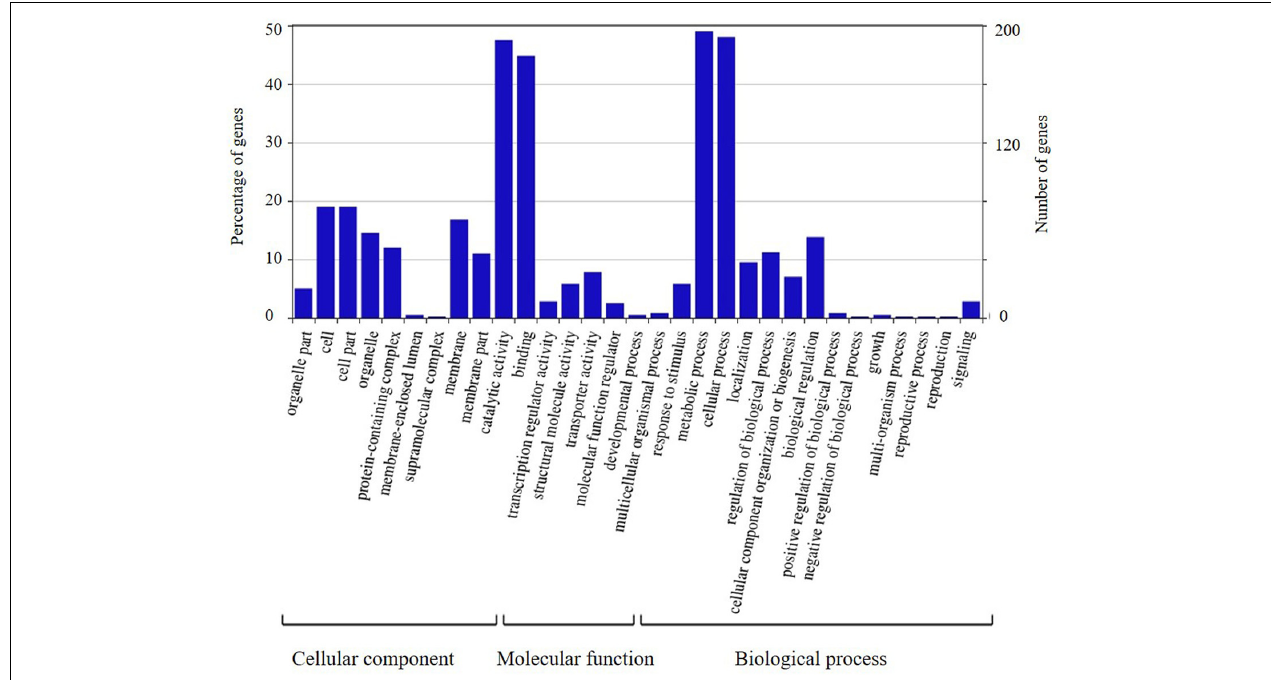
FIGURE 8 | Annotation information of genes in the high confidence interval of QTL detected on chromosome 4 through Gene ontology (GO) analysis.